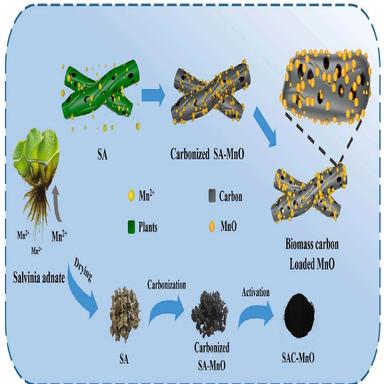
Schematic of preparation process for SAC-MnO.